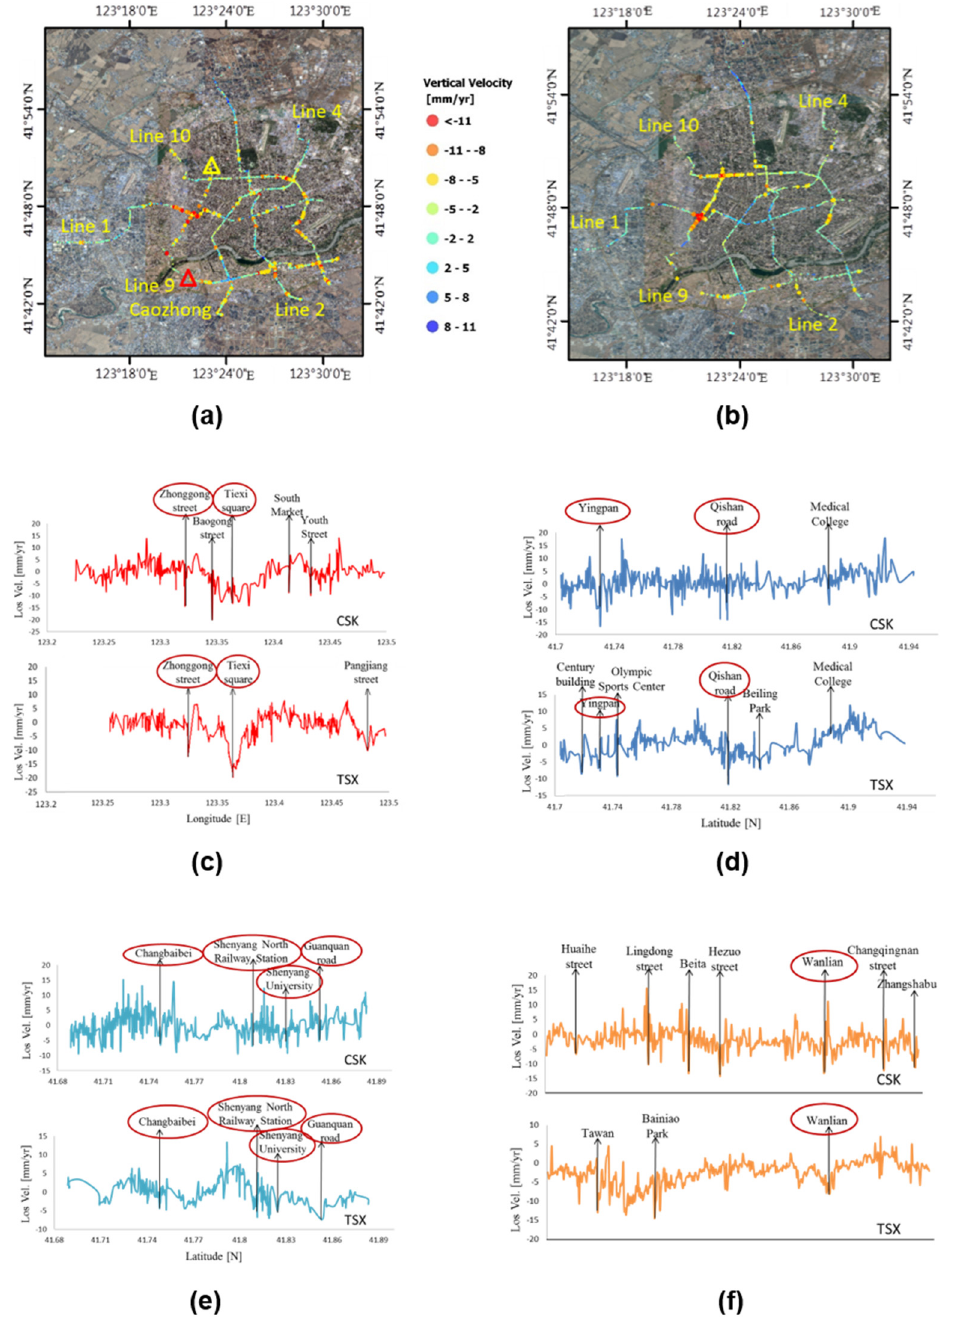
Figure 13. Comparison of displacement velocity profiles from ( a ) CSK and ( b ) TSK and analysis with respect to subway tunnels: profile along lines ( c ) 1, ( d ) 2, ( e ) 4, and ( f ) 10.